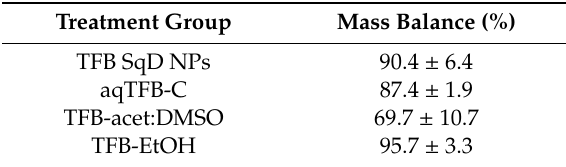
Table 4. Mass balance of TFB applied on application area in ex vivo pig ear skin experiment. Results are presented as mean ±